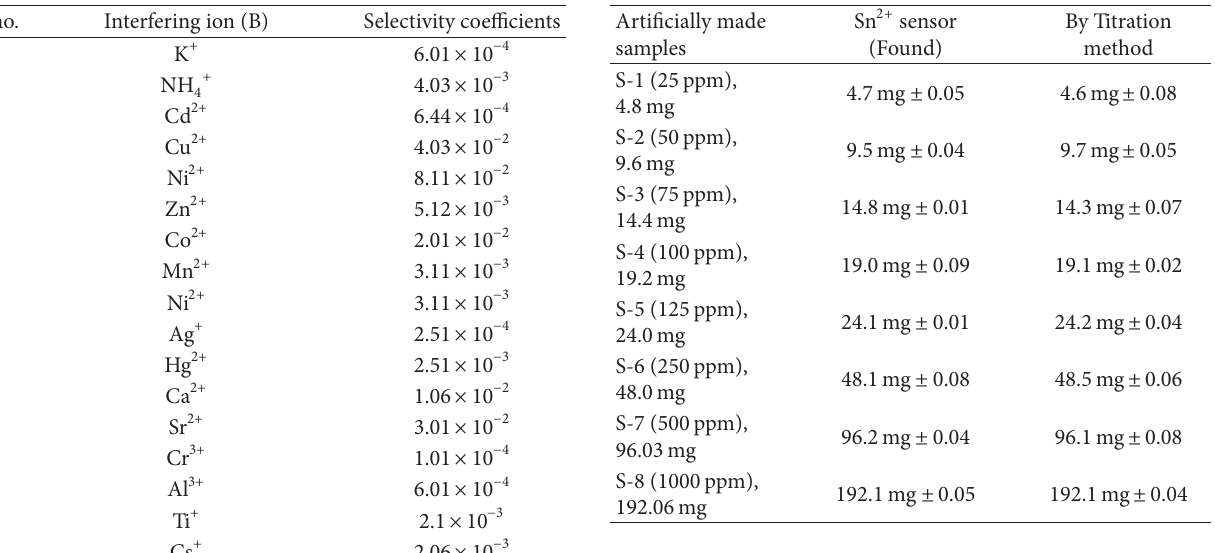
T 3: Selectivity coefficient values selective sensor T 4: Determination of